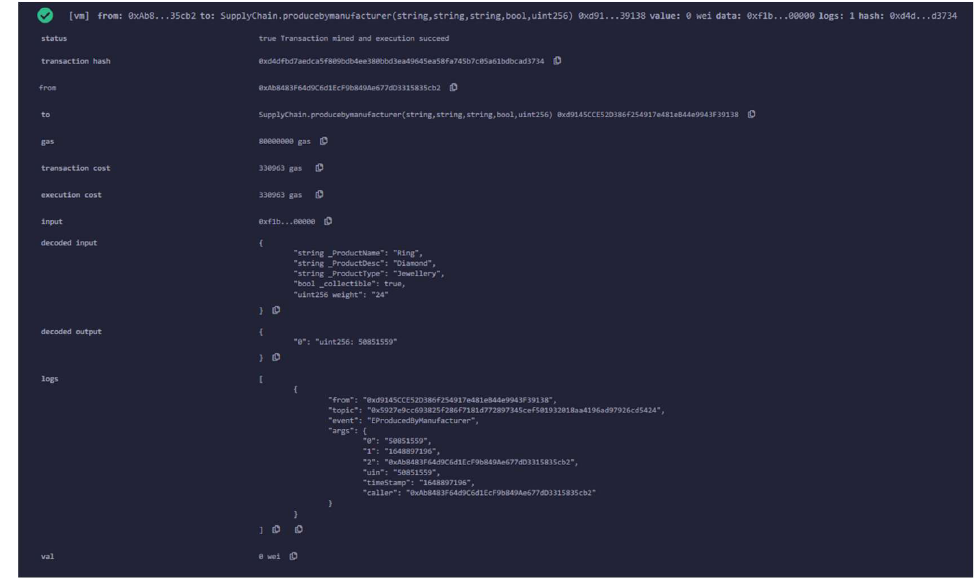
Fig. 8. Product is successfully added to the blockchain.